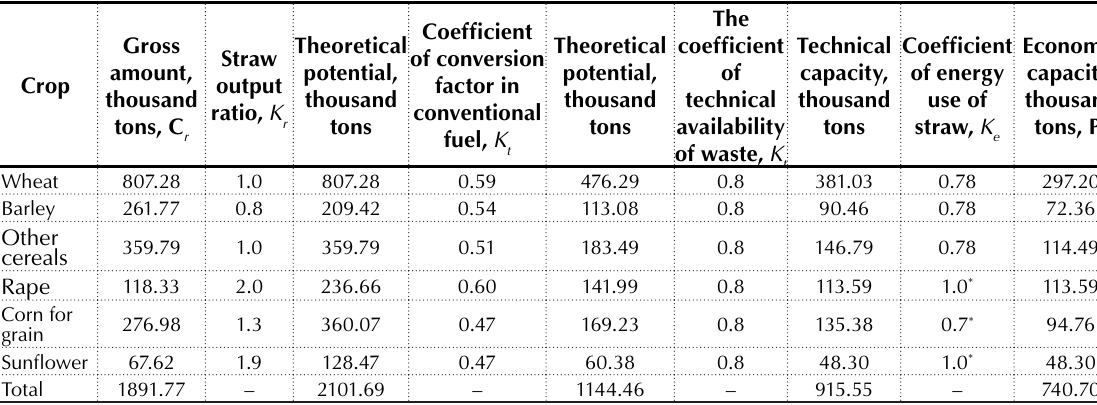
) of agricultural waste in the Lviv region for е